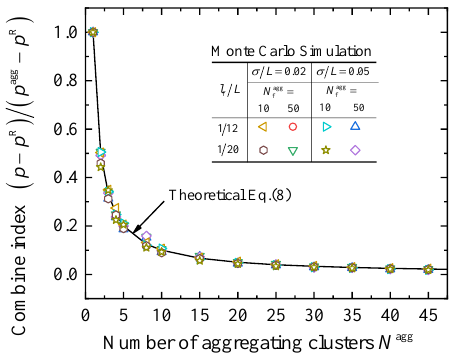
Figure 3. Validation of the average intersecting probability.